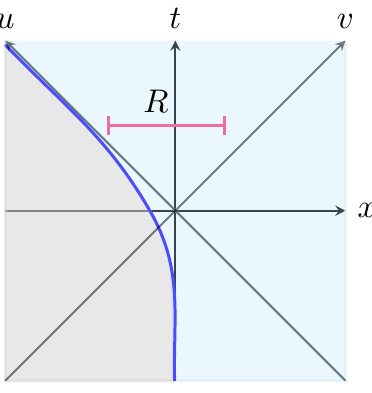
Figure 7 . A mirror trajectory describing an eternal black hole (3.19). It starts from x = 0 and asymptotes to the light-ray t = − x at late time. The entropy and capacity of entanglement are probed by the interval R = [ z ( t ) + 0 . 1 , z ( t ) + 10] at a fixed distance from the mirror.